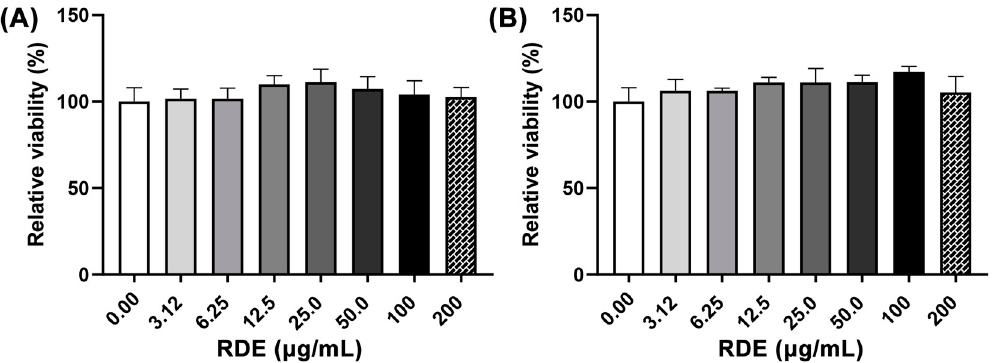
Figure 1. Dose-effects of red-osier dogwood extracts (RDE) on the viability of Caco-2 ( A ) and Caco-2 BBe1 cells ( B ). Cells were seeded into a 96-well plate and cultured until 90% confluence was reached, and then treated with different concentrations of RDE for 24 h. Cell viability was measured using a WST-1 kit. Values are presented as means ± SEM, n = 4.